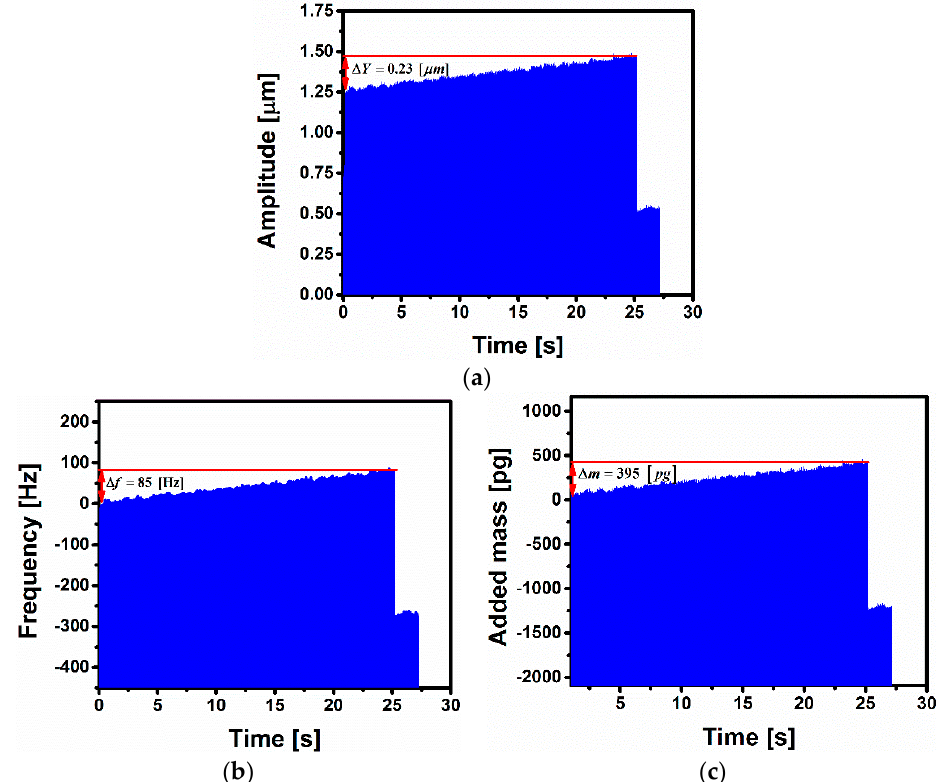
Figure 9. Time history of electrostatically actuated microbeam upon gas exposure ( a ) amplitude variation; ( b ) Frequency shift and ( c ) Added mass as a function of time.